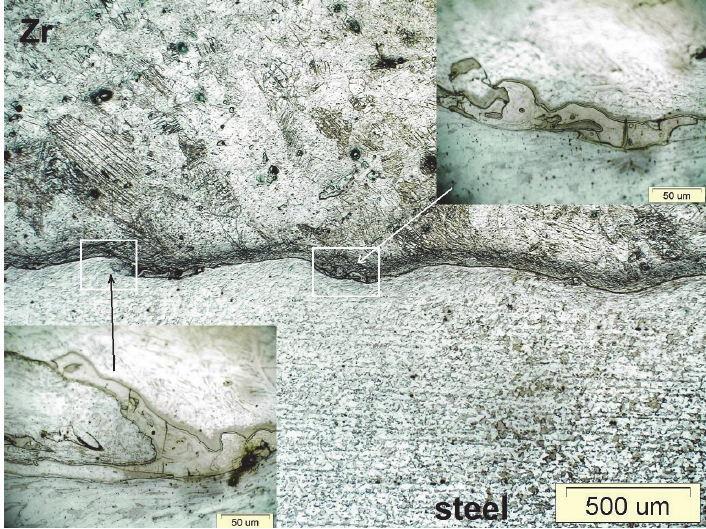
Figure 4: The microstructure of the bimetal joining zone with melted layer - crest of wave.